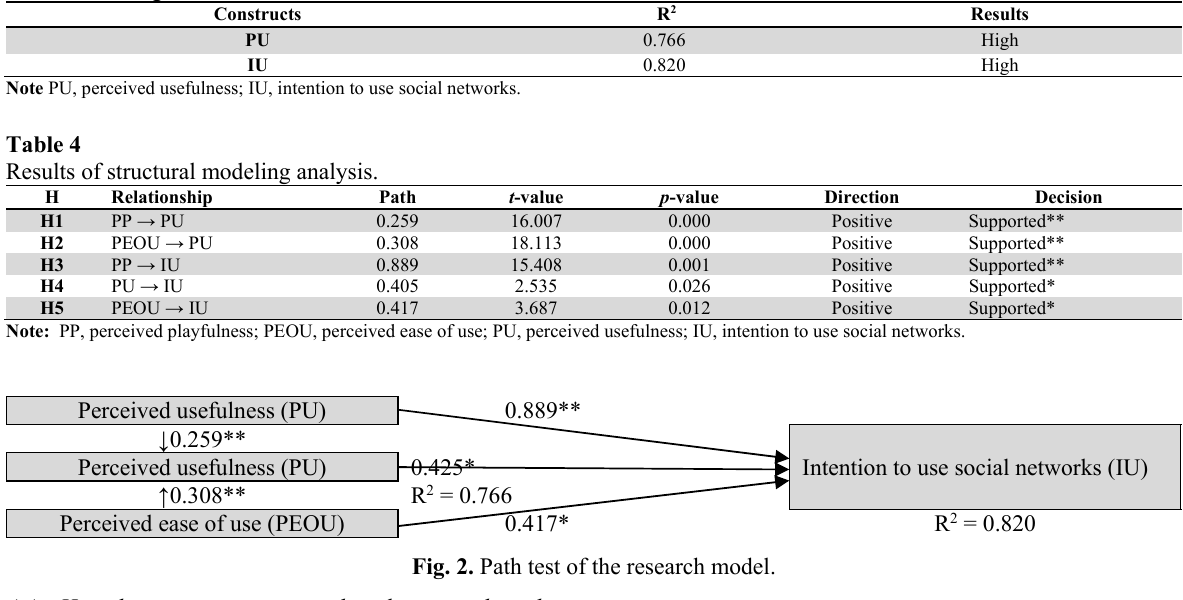
“R 2 of the endogenous latent variables”.